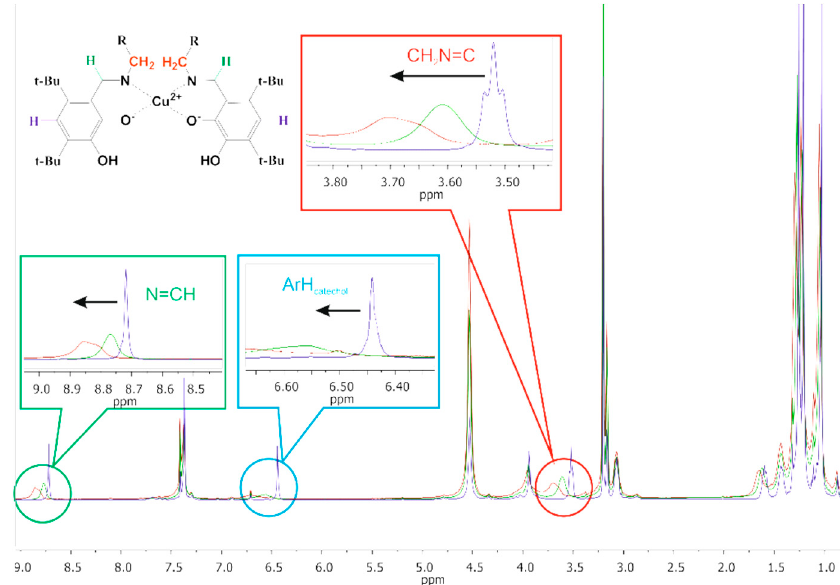
Figure 5. 1 H NMR spectra of compound 10 (10 mM) in CD 3 OD:CDCl 3 (1:1) upon addition of 0 equiv (blue), 0.5 equiv (green), and 1 equiv of Cu 2+ (red).